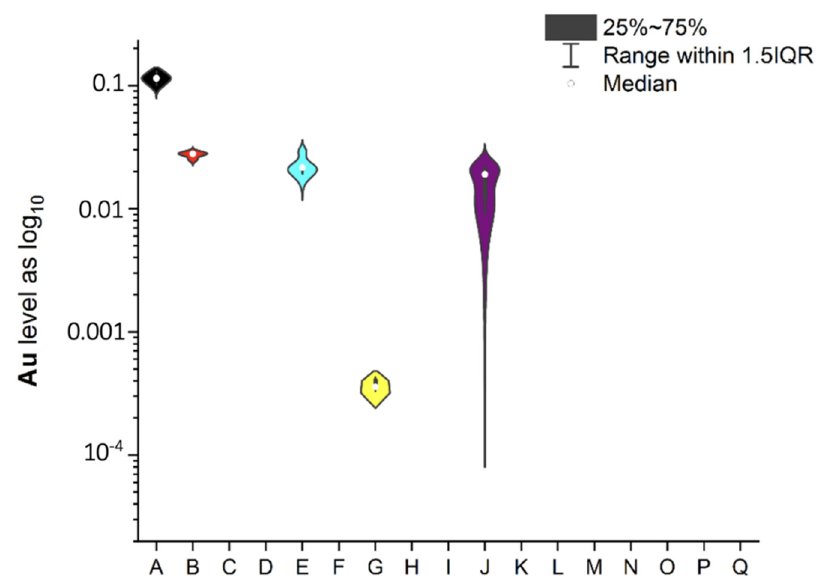
Figure 2. The plot as a violin with the box for the Au level in a log 10 scale in examined products. (i.e., A, B, E, G, and J).